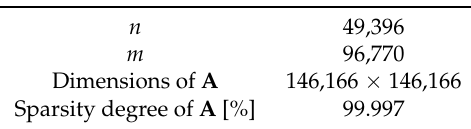
Table 12. ENTSO-E: statistics.